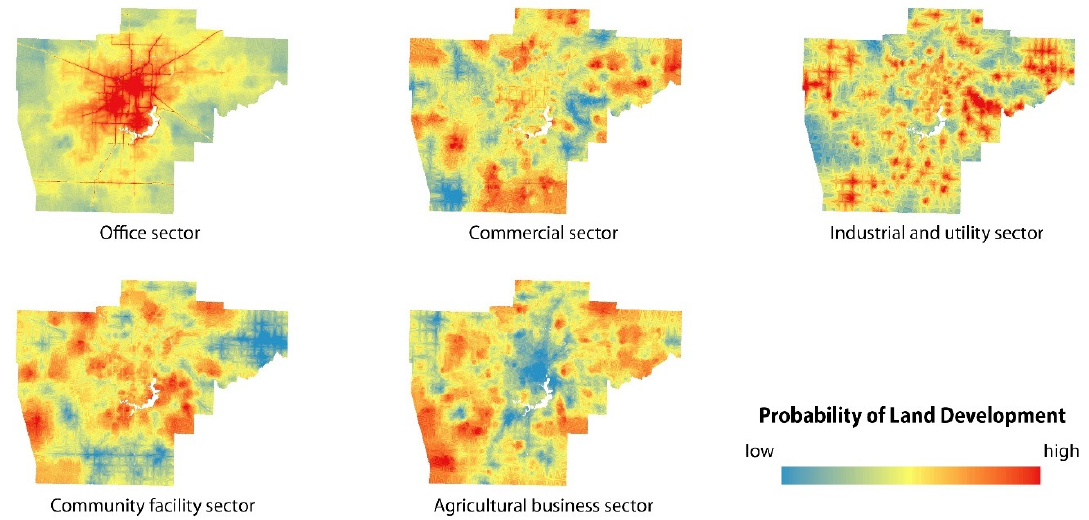
Figure 8. Probability maps for five commercial sectors. Each map exhibits the possibility of location choice of each sectoral development. Five probability maps were computed using ridge-regression methods.